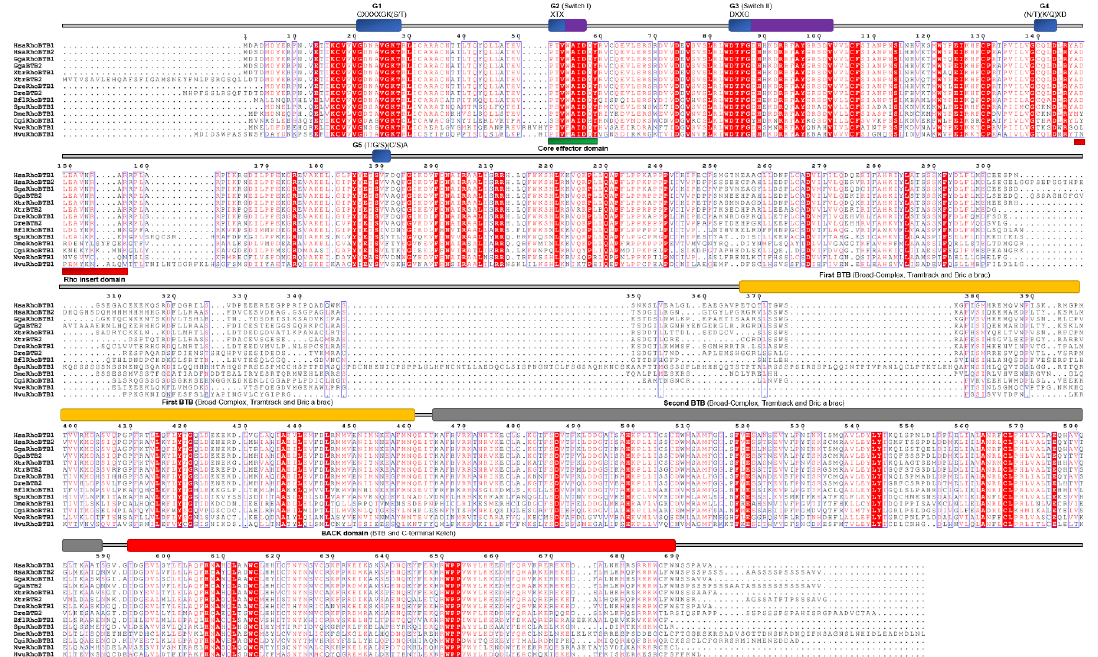
Figure 10. Sequence alignment of the RhoBTB subfamily. The amino acid sequences of RhoBTB GTPases were aligned using ClustalX, the secondary structures predicted using ESPript. Regions of the Rho proteins are indicated above the alignment; blue are the G domains, (G1, G2, G3, G4, and G5 with their respected motifs), purple are switch 1 and switch 2 domains, orange the first BTB domain, gray the second BTB domain, and red represents the C-terminus back domain. Blue frames are indicators of the conserved residues; white letters in red boxes represent identity, red letters in white boxes represent similarity.